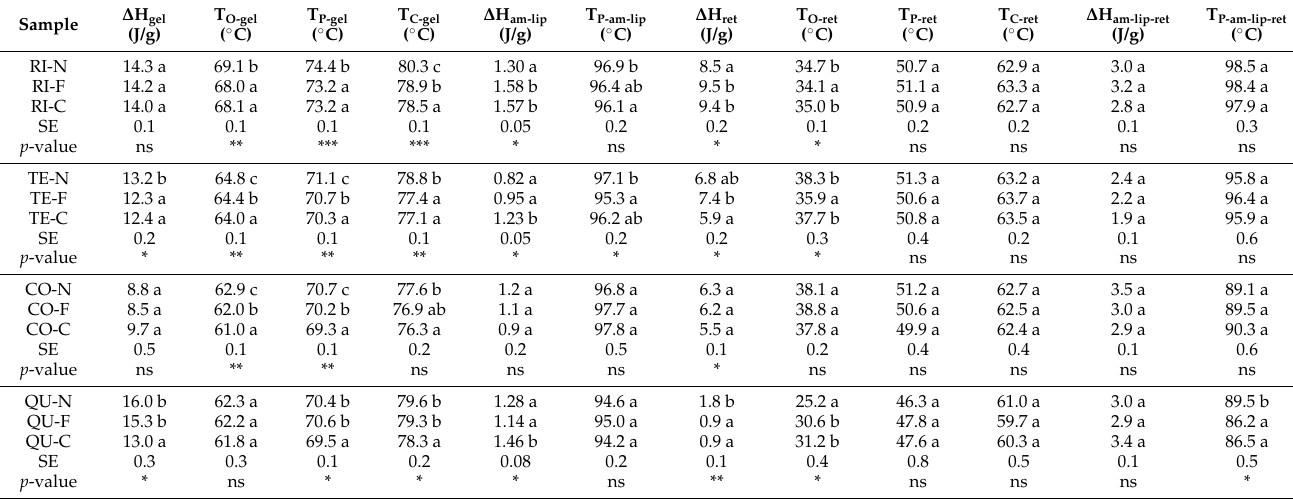
Table 5. Thermal properties of the native and ultrasonicated